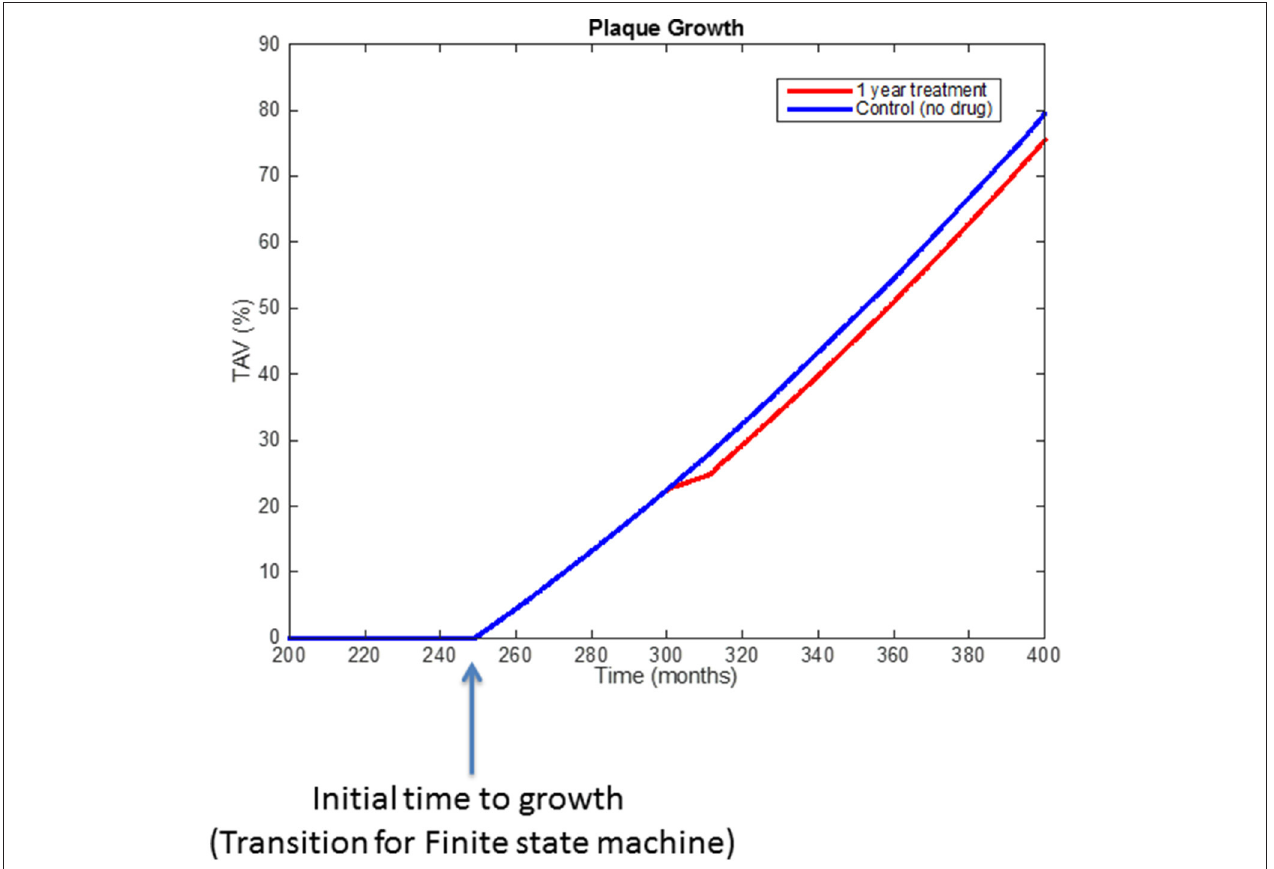
FIGURE 9 | Comparison of simulation results using the original physical-based model of atherosclerosis (blue line) and the effect on plaque growth when a one-year statin treatment is considered on the model (red